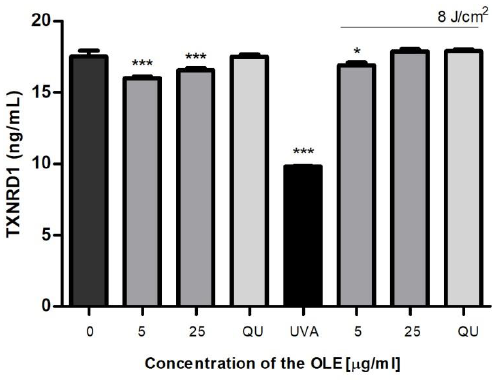
Figure 6. The level of thioredoxin reductase (TxnR) in human skin fibroblasts untreated (0) or pre- incubated (24 h) with OLE (5 and 25 μg/mL) or reference antioxidants (25 μg/mL) and exposed (or not exposed) to UVA (8 J/cm 2 ). Mean values ± SD of three independent experiments is presented. Statistically significant differences vs. non-treated group (control); * p < 0.05; *** p < 0.001.